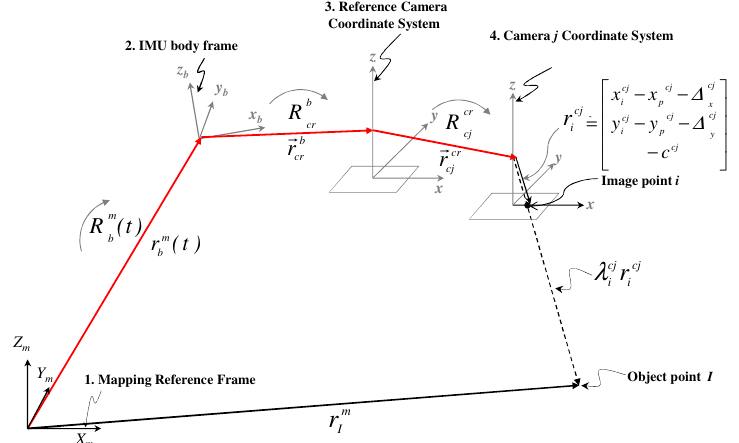
Figure 2. Involved parameters in the vector summation process to derive the modified collinearity equations for GPS/INS-assisted The new point positioning mathematical model, presented in Equation 3, is derived through the summation of four vectors, )t(r m b